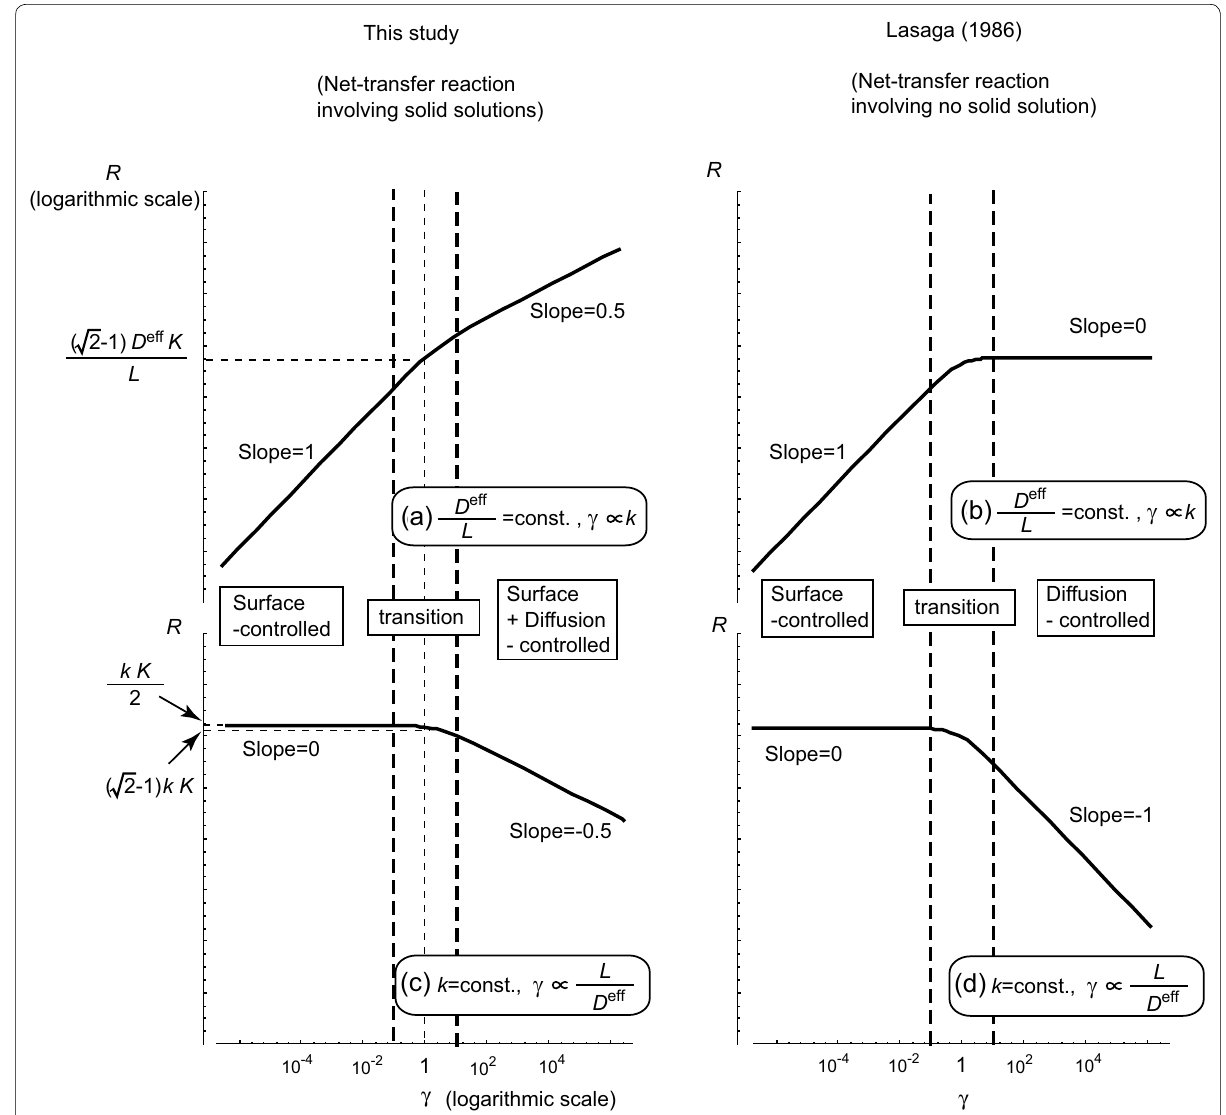
Fig. 6 The double logarithmic plots of the reaction rates as a function of γ when δ = 1 . The results of this study for net-transfer reactions involving a solid solution are denoted in a and c . For comparison, the results of the case of net-transfer reactions that do not involve a solid solution (Lasaga 1986) are denoted in b and d . Upper: a and c denote the results for the case when D eff / L is constant to depict the dependency of the reaction rate R on the surface reaction rate constant k . Lower: b and d denote the results when k is constant to denote the dependency of R on the intergranular diffusion constant, D eff . The slopes in the upper and lower graphs refer to k and L / D eff , respectively, implying a controlled reaction process, which is written in the rectangular